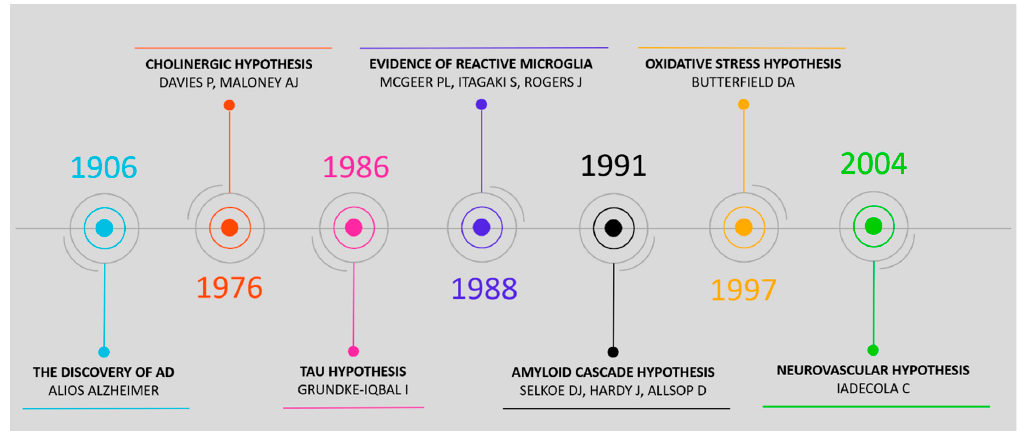
Figure 1. Timeline showing the pathophysiological hypotheses of Alzheimer’s disease: the cholinergic hypothesis [31], tau hypothesis [32], evidence of reactive microglia [33], amyloid cascade hypothesis [34,35], oxidative stress hypothesis [36], and neurovascular hypothesis [37].